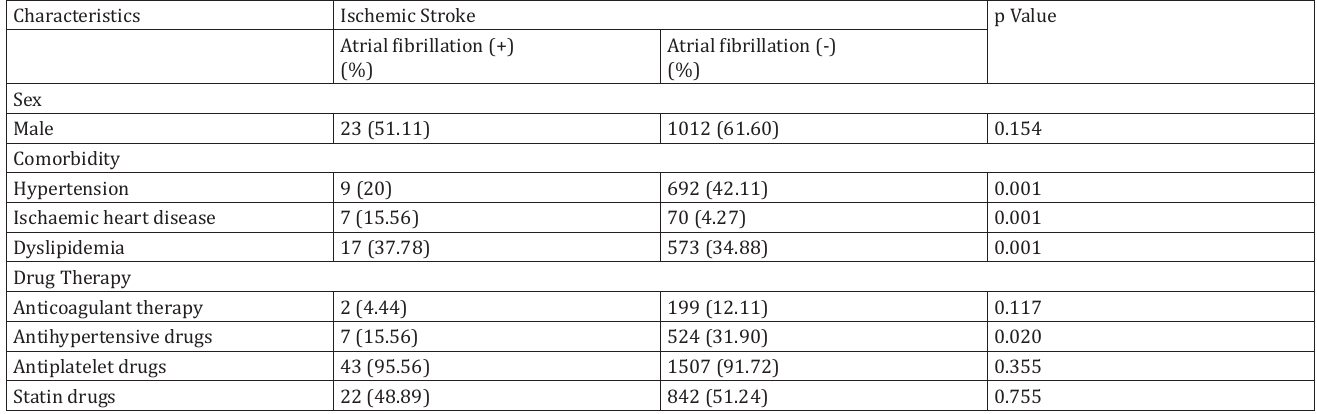
Comparison of baseline characteristics of ischemic stroke patients with atrial fibrillation and without atrial fibrillation. Characteristics Ischemic Stroke Atrial fibrillation (+) (%)